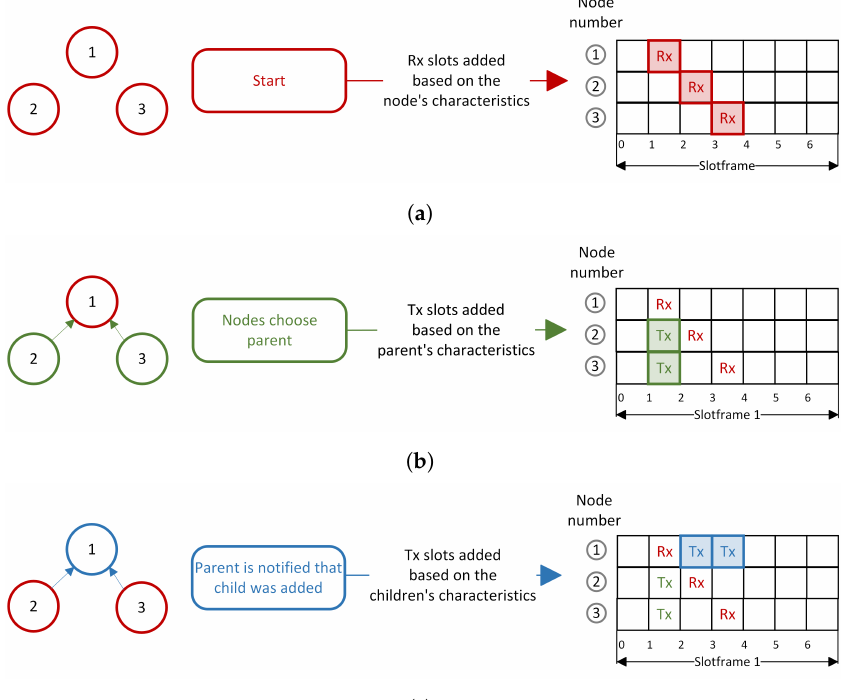
Figure 4. Initialization phase: allocation of Rx and Tx slots. ( a ) Initialization phase step 1: Rx slots are allocated for each node. ( b ) Initialization phase step 2: Tx slots are allocated for children to communicate with parent. ( c ) Initialization phase step 3: Tx slots are allocated for the parent to communicate with